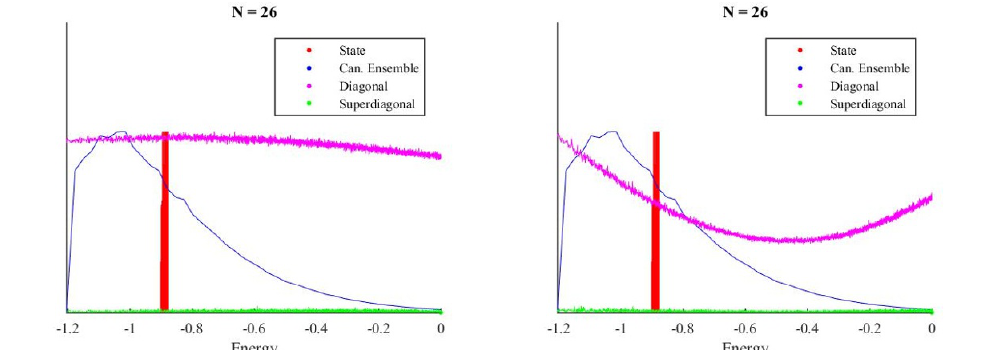
Figure 16 . We compare the diagonal (magenta) matrix elements of f 1 ( t (cid:3) ) ; 2 (0) g 2 (left) and (cid:0) [ S 1 ( t (cid:3) ) ; S 2 (0)] 2 (right), where t (cid:3) is the scrambling time. They, moreover, dominate the elements just above the diagonal (green). The regions important for the typical state (red) and the canonical ensemble (blue, (cid:26) ( E ) e (cid:0) (cid:12)E ) are shown as well. The operators were not passed through a low pass